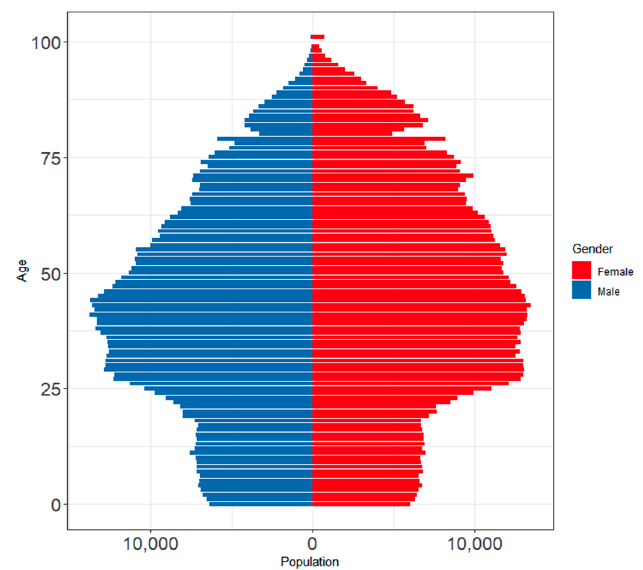
Figure 1. Barcelona’s population pyramid, 2020.